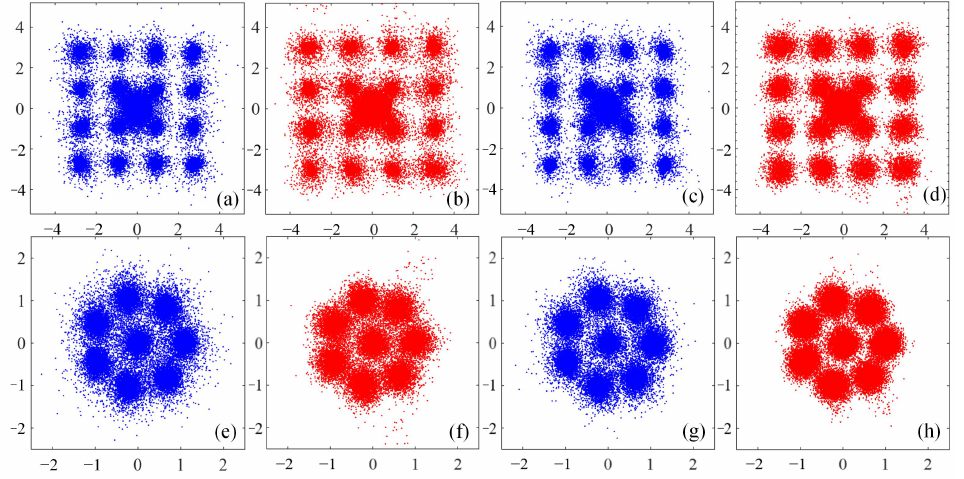
Figure 10. The received constellation diagrams for: ( a ) OFDM-SM-IM, 16QAM, 50 cm, with- out interleaving, ( b ) DFT-S-OFDM-SM-IM, 16QAM, 50 cm, without interleaving, ( c ) OFDM-SM- IM, 16QAM, 50 cm, with interleaving, ( d ) DFT-S-OFDM-SM-IM, 16QAM, 50 cm, with interleaving, ( e ) OFDM-DM-IM, circular (7,1)QAM, 60 cm, without interleaving, ( f ) DFT-S-OFDM-DM-IM, circular (7,1)QAM, 60 cm, without interleaving, ( g ) OFDM-DM-IM, circular (7,1)QAM, 60 cm, with interleav- ing, and ( h ) DFT-S-OFDM-DM-IM, circular (7,1)QAM, 60 cm, with